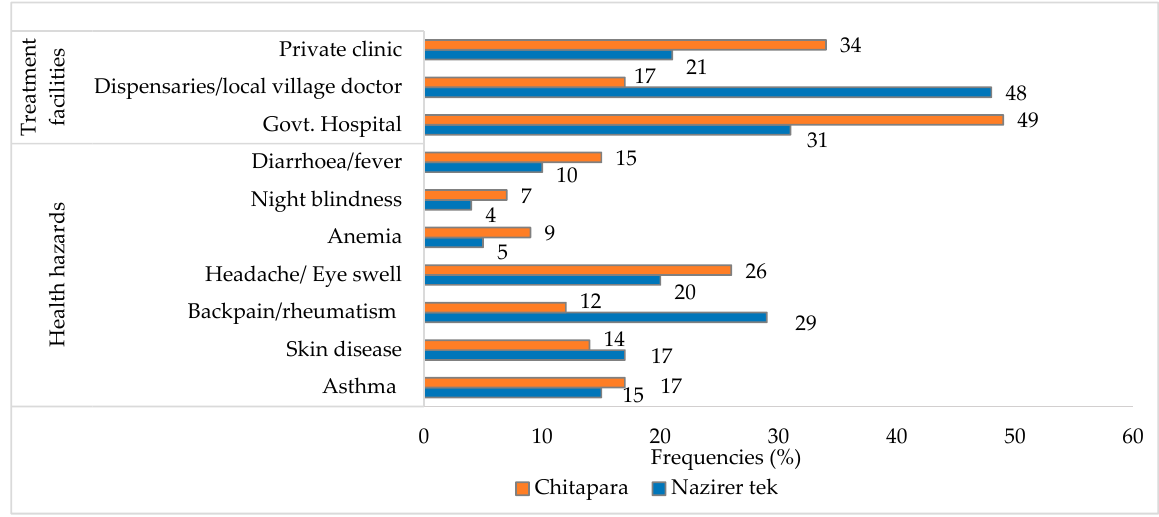
Figure 6. Occupational hazards and treatment facilities of the communities involved in fish drying practices.